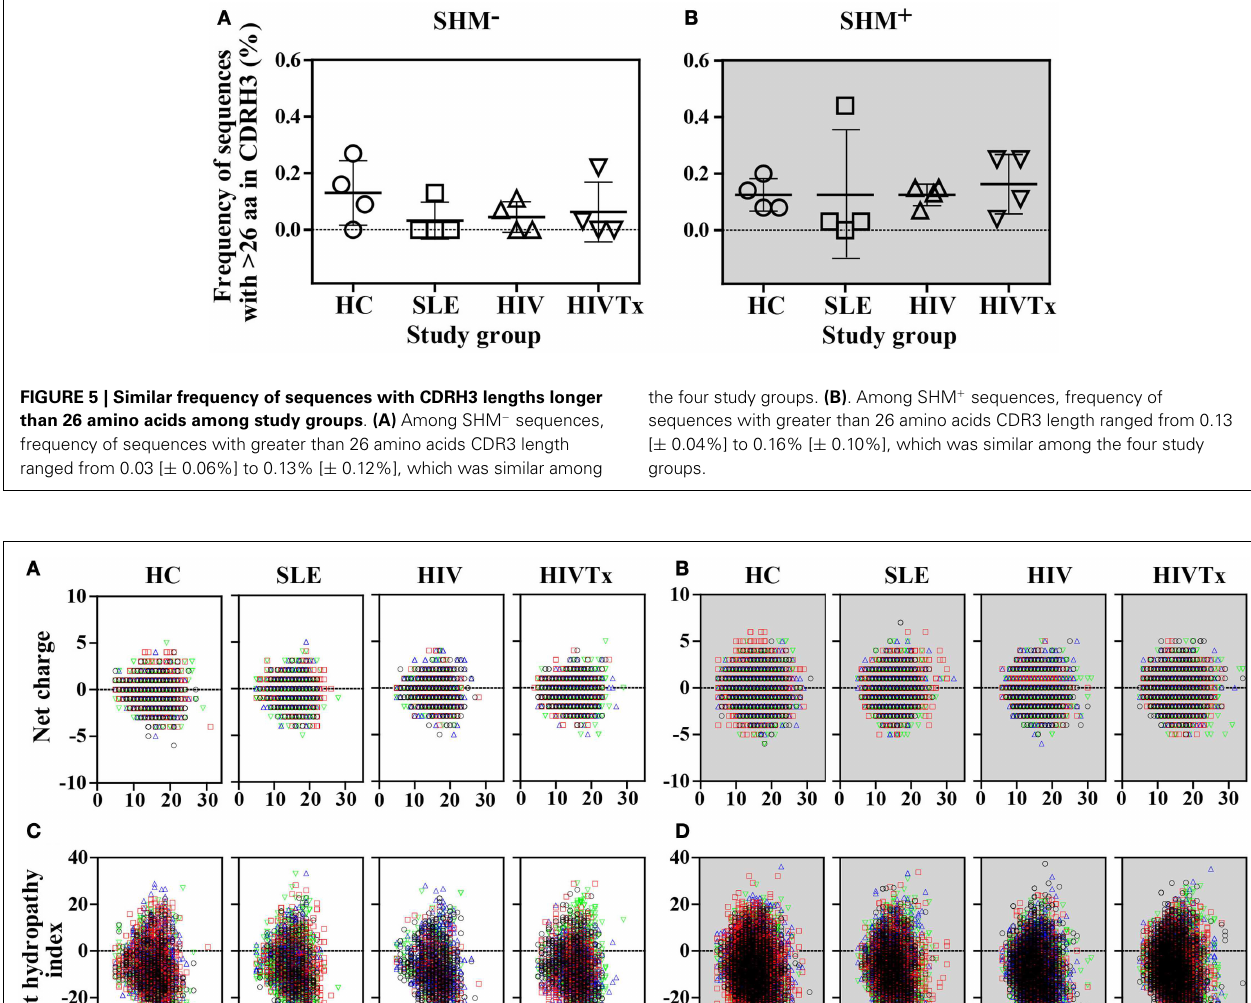
FIGURE 6 | Similar distribution of charge and hydropathy across IGHM CDRH3 length among study groups . Distribution of charge and hydropathy across IGHM CDRH3 amino acid length range were similar among the four study groups in sequences without [charge, (A) ; hydropathy index, (C) ] or with SHM [charge, (B) ; hydropathy index, (D)